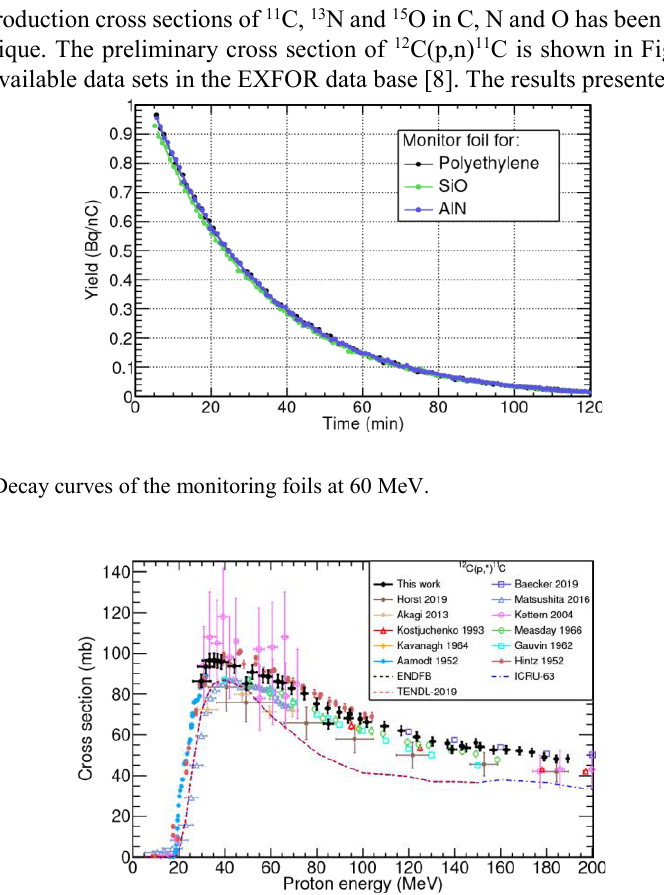
Figure 5. Preliminary production cross section of 12 C(p,pn) 11